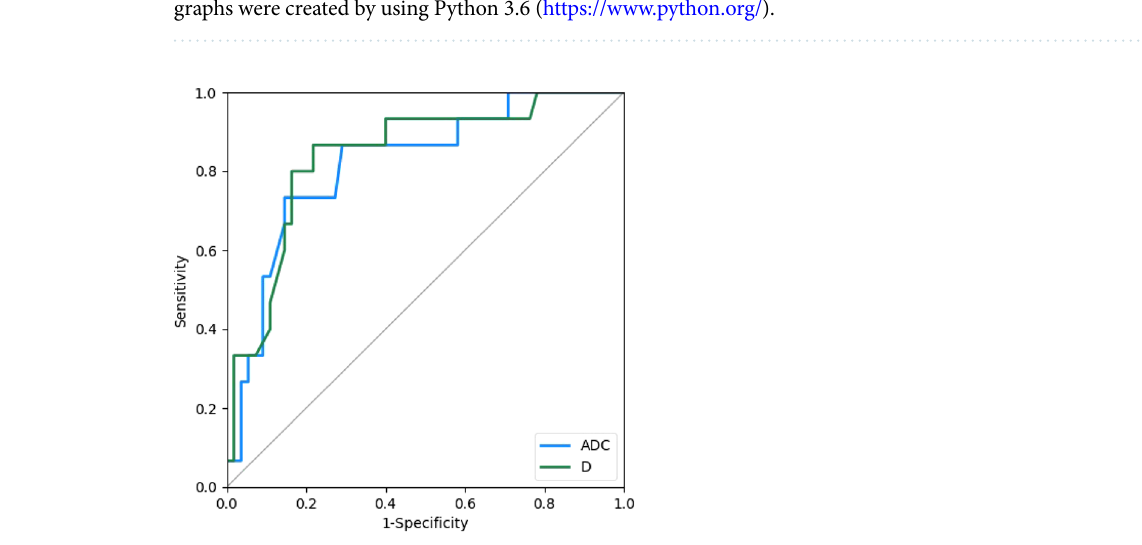
Figure 4. Scatter plots showing IVIM-DWI parameters in different HCC histologic differentiation groups.The graphs were created by using Python 3.6 (https:// www. python. org/).